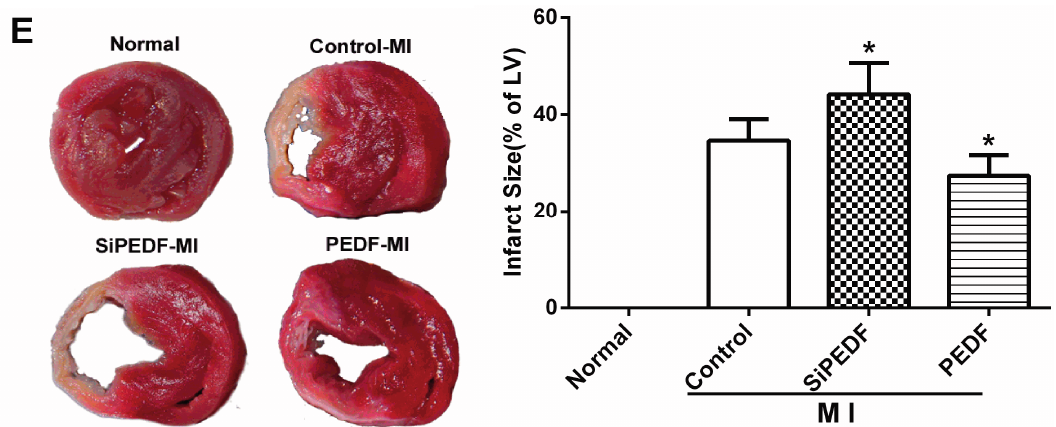
Figure 1. Myocardial infarct size of the left ventricle and cardiac function determination. ( A ) Left ventricular fractional shortening; ( B ) Left ventricular ejection fraction; ( C ) Left ventricular end-systolic volume (ESV); ( D ) Left ventricular end-diastolic volume (EDV); ( E ) Representative figures of the 2,3,5-triphenyltetrazolium (TTC)-stained myocardial tissues at four weeks after acute myocardial infarction (AMI) in each indicated experimental condition and quantification of the infarct size. Data are expressed as the mean ± SD ( n = 6). * p < 0.05 vs. the control group; NS, No statistical difference; MI, myocardial infarction; PEDF: pigment epithelium-derived